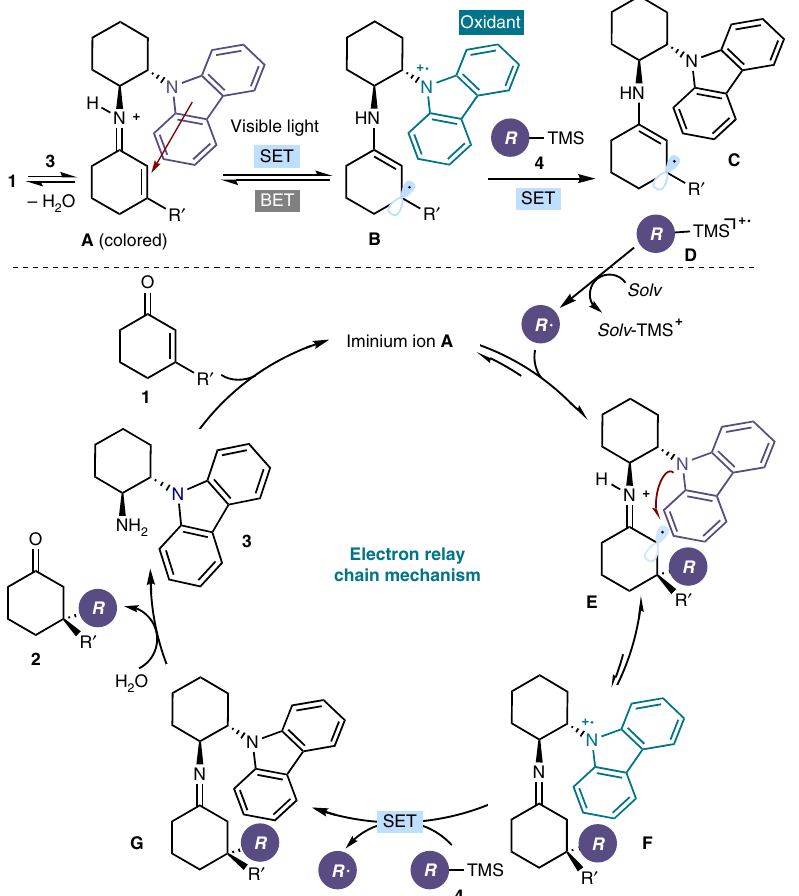
Fig. 3 Mechanistic proposal. Central to this study is the ability of the carbazole radical cation within B , generated upon visible-light excitation of the intramolecular EDA complex A , to drive the generation of radicals acting as an SET oxidant. SET single-electron transfer, BET back-electron transfer, Solv solvent, TMS